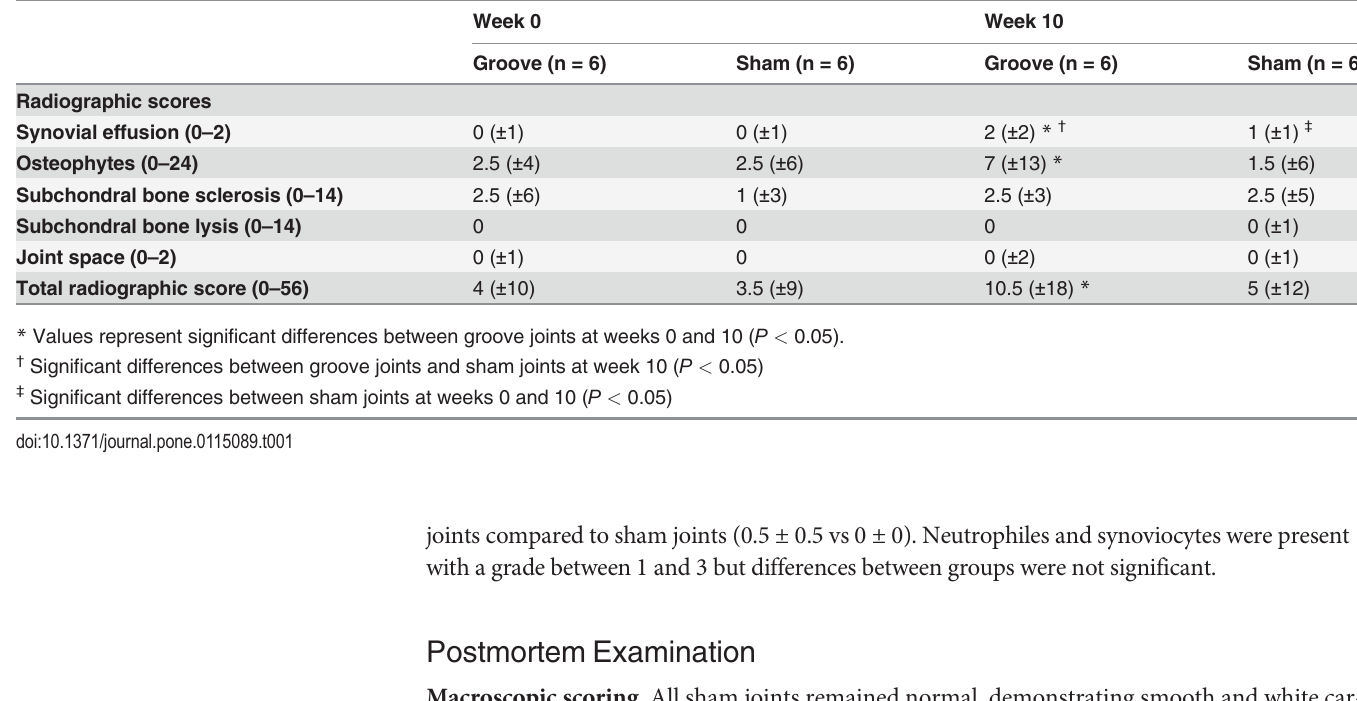
Table 1. Median radiographic scores ( ± median absolute deviation) for groove and sham joints at weeks 0 and 10.